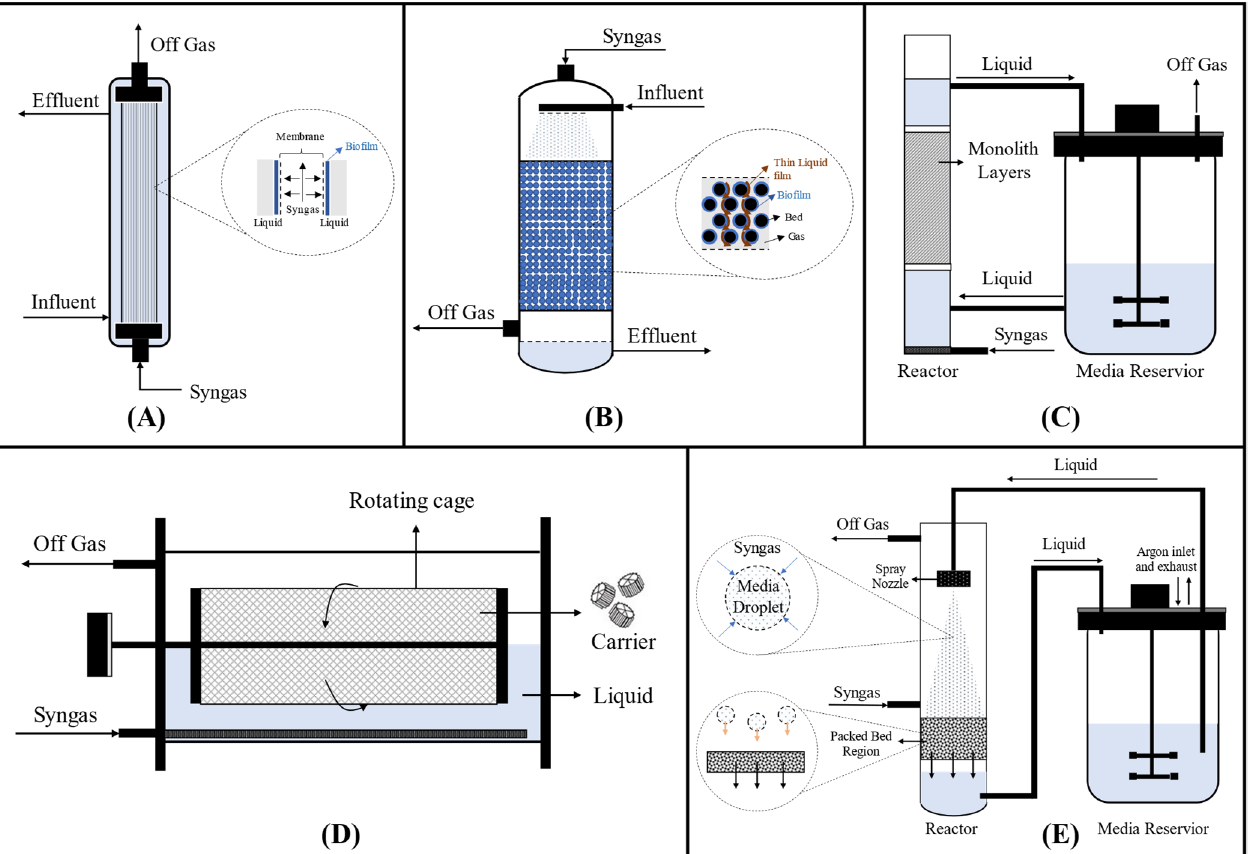
Figure 4. Schematic description of biofilm reactors: ( A ) Hollow-fiber membrane biofilm reactor ( B ) Trickle bed reactor ( C ) Monolithic biofilm reactor ( D ) Rotating packed bed biofilm reactor ( E ) Bulk-gas-to-atomized-liquid